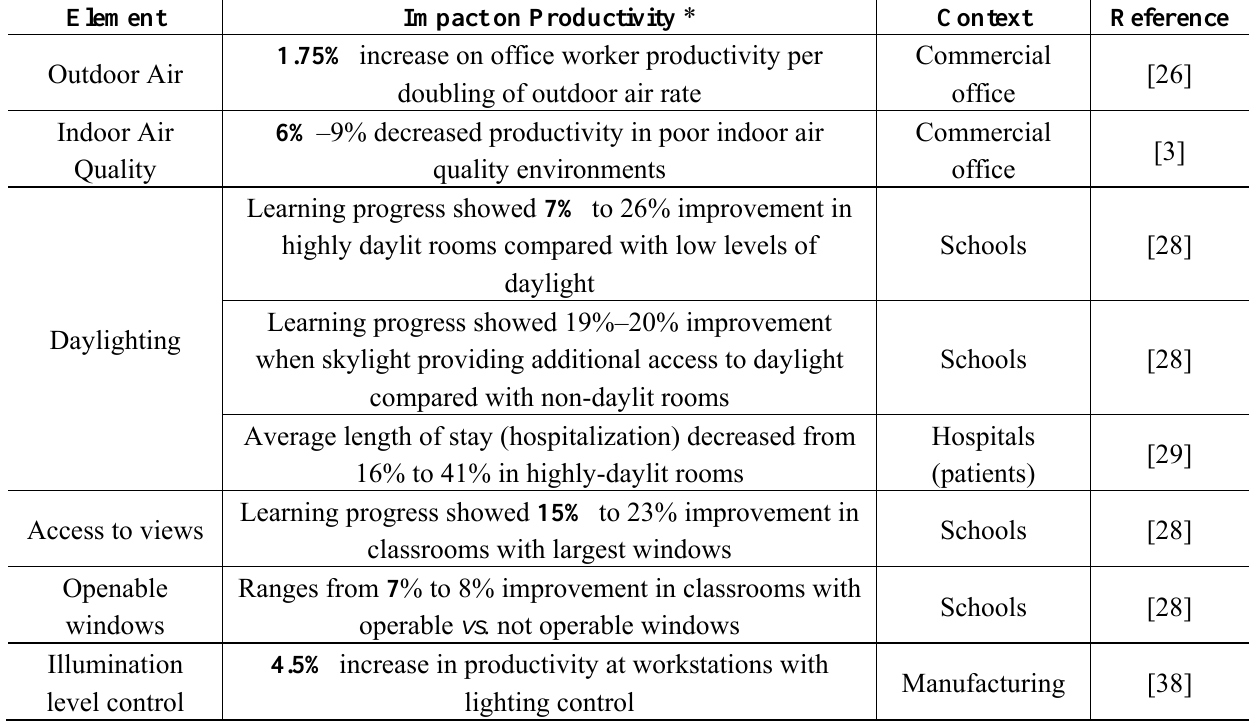
Table 2. Potential drivers and priorities to guide renovation bundle